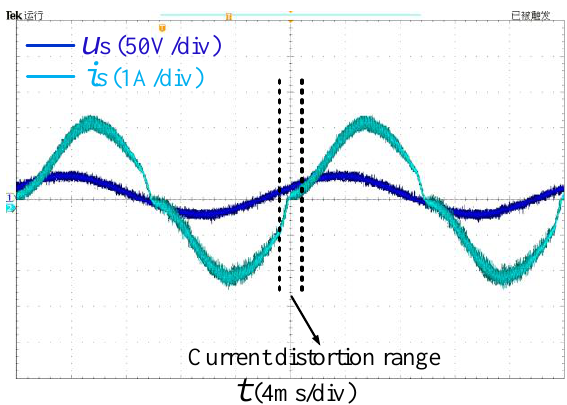
Figure 25. Experiment waveforms of grid voltage and input current when is lags us by 8°.